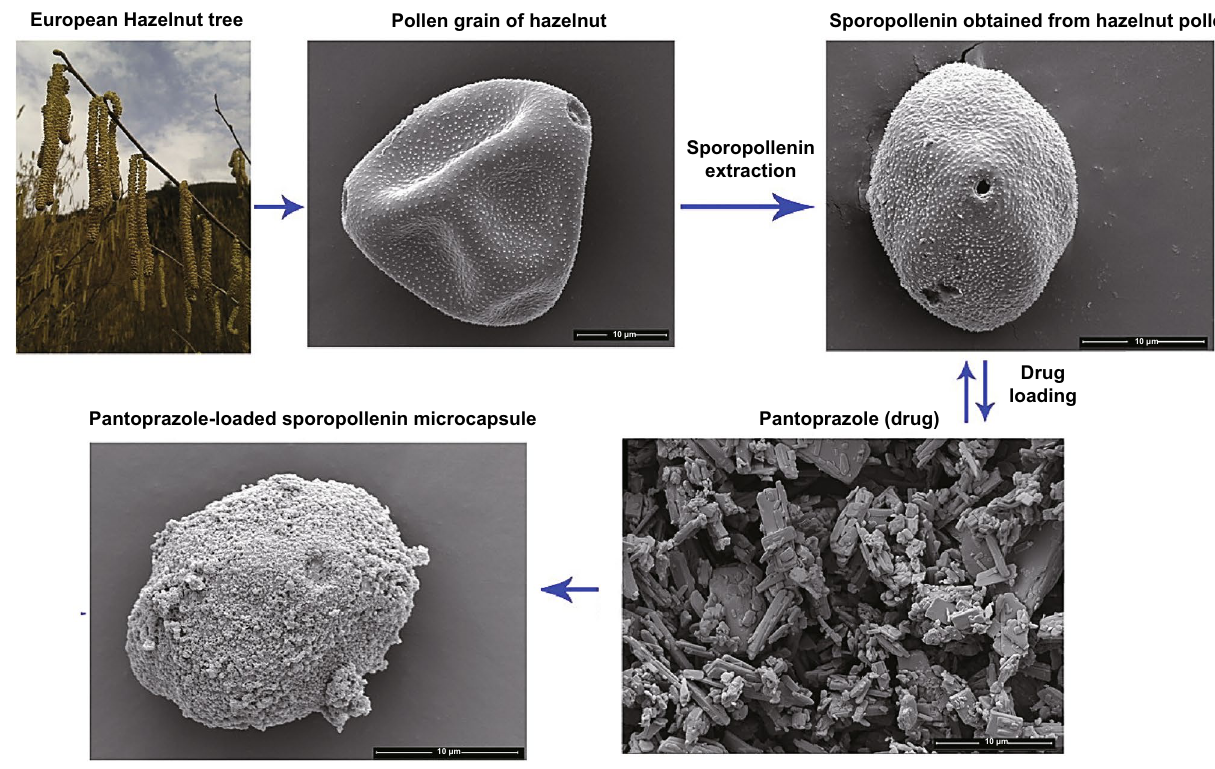
Fig. 6 Production procedures of pollen-derived microcarriers for pantoprazole delivery. Reproduced with permission from Ref. [45]. (Color figure